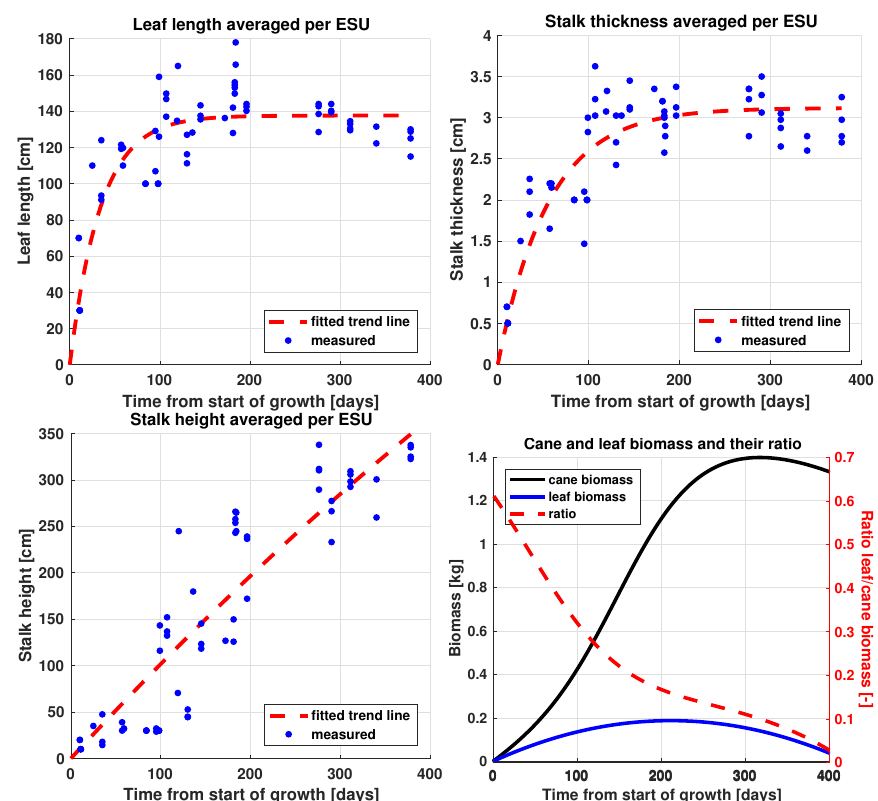
Figure 5. Temporal developments of measured leaf length, stalk thickness, and stalk height, averaged per ESU and accompanied by fitted trend lines. The cane and leaf biomass (in kg) per cane and their ratio over time are based on the trend lines of individual stalk- and leaf-biomass